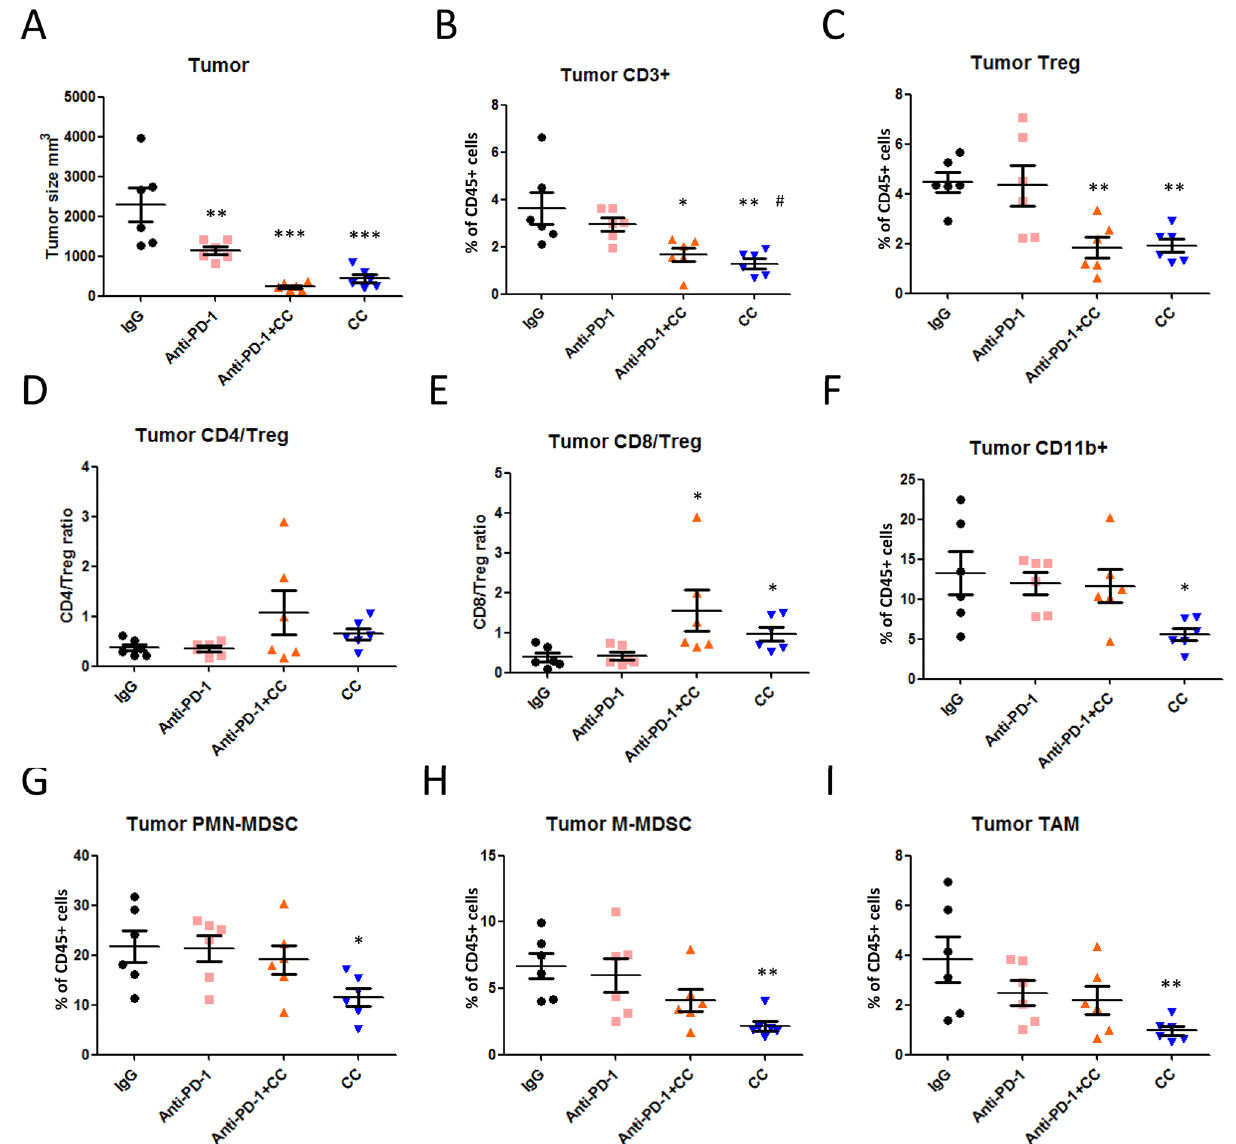
Figure 6. Infiltrating immune cell populations of lymphocytes and myeloid-derived MDSCs in tumors. ( A ) CT26 tumor-bearing mice were orally administered a chidamide-k30 solution and celecoxib (50 mg/kg) once daily from days 10 to 22 (Day 10 mean tumor volume (TV), 220–240 mm 3 ). Endpoint tumor size is presented as TV (mm 3 ) performed on day 12 after initial treatment. Results are shown as mean ± standard deviation (SD). **p < 0.01 or ***p < 0.001 vs. anti-IgG. Tumor-infiltrating lymphocytes were isolated by the Percoll gradient centrifugation method. ( B,C ) Percentages of CD3 + T cells and Tregs in tumors by flow cytometric analysis. Results are shown as mean ± SD. *p < 0.05 or **p < 0.01 vs. anti-IgG; # p < 0.05 vs. anti-PD-1. ( D,E ) CD4/Treg and CD8/Treg ratios in tumors by flow cytometric analysis. Results are shown as mean ± SD. *p < 0.05 vs. anti-IgG. ( F ) Flow cytometric analysis of myeloid-derived CD11b + cells in tumors. Results are shown as mean ± SD. *p < 0.05 vs. anti-IgG. ( G,H ) Flow cytometric analysis of myeloid-derived PMN-MDSC and M-MDSC cell populations in tumors. Results are shown as mean ± SD. *p < 0.05 or **p < 0.01 vs. anti-IgG. ( I ) Flow cytometric analysis of myeloid-derived Ly6C + /MHCll + tumor-associated macrophages in tumors. Results are shown as mean ± SD. *p < 0.05 vs.